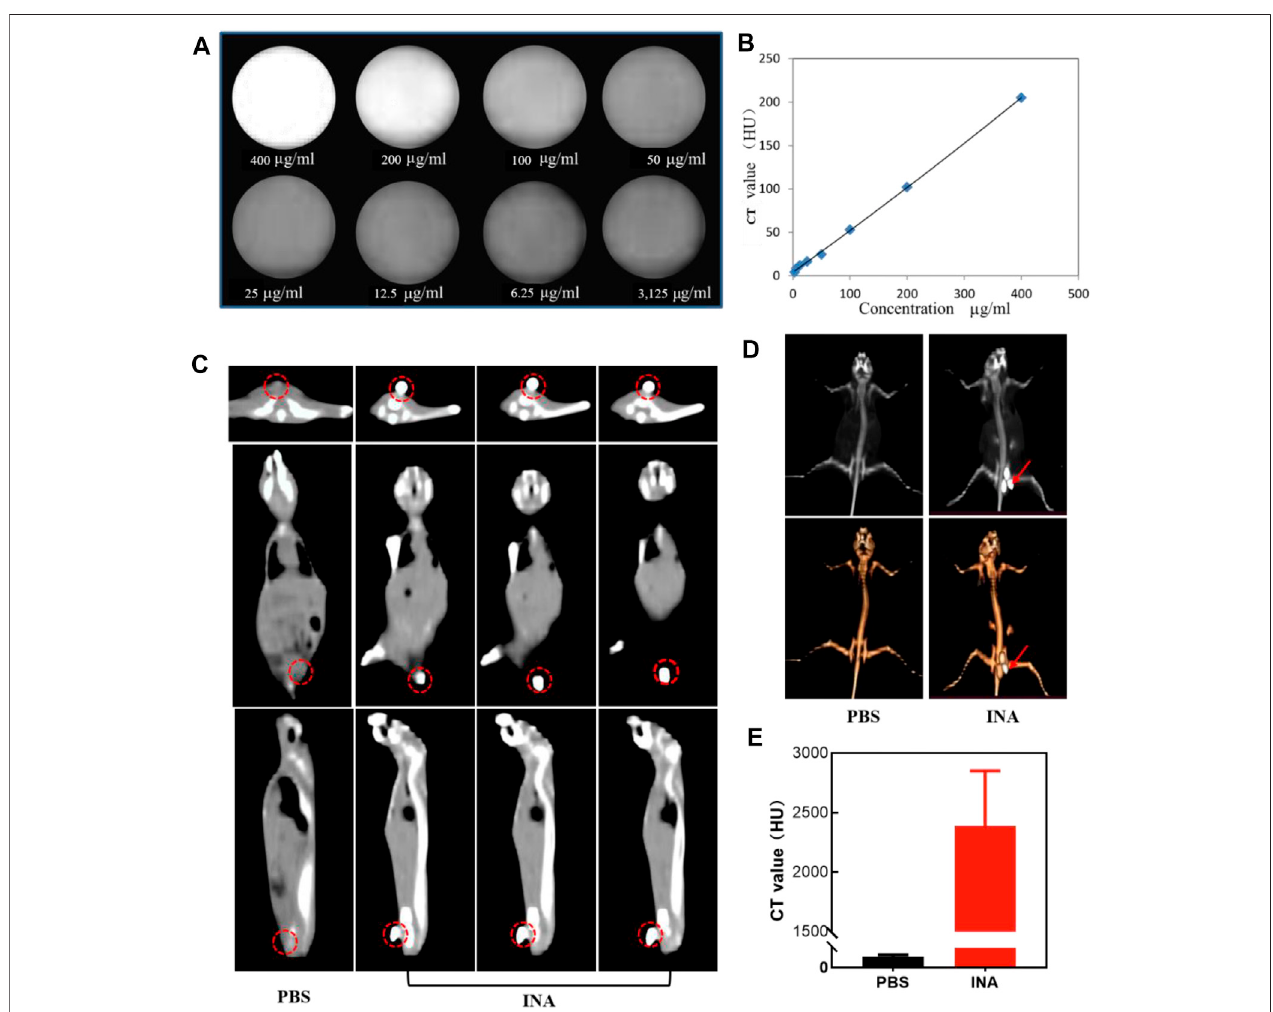
FIGURE 4 | (A,B) CT images and the corresponding plot of the CT value (HU) of INA at different concentrations. (C) Axial, coronal, and sagittal CT images of 4T1 tumor – bearing mice after intratumoralinjection ofPBSor INA. Red circles indicate thelocationof thetumors. (D) 3D reconstruction images from CTscan images of4T1 tumor – bearing mice after intratumoral injection of PBS or INA. Red arrows indicate the location of the tumors. (E) Corresponding CT values of tumors after intratumoral injection of PBS or INA.